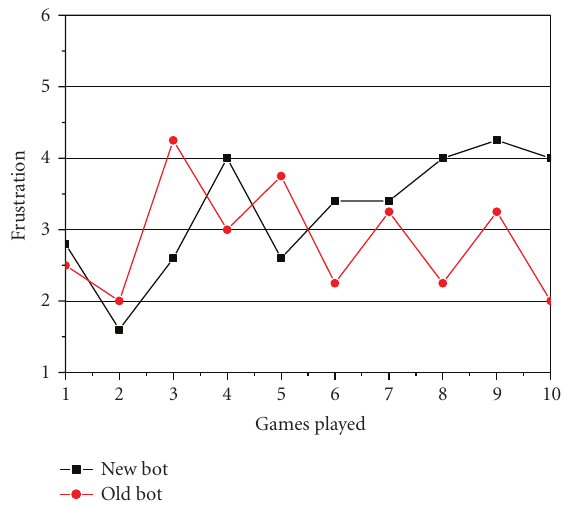
Figure 14: Comparison of survey results on the frustration (range from 1 = very low to 6 = very high) after each played game. Introversions bot is shown in red, while the new bot is shown in black.